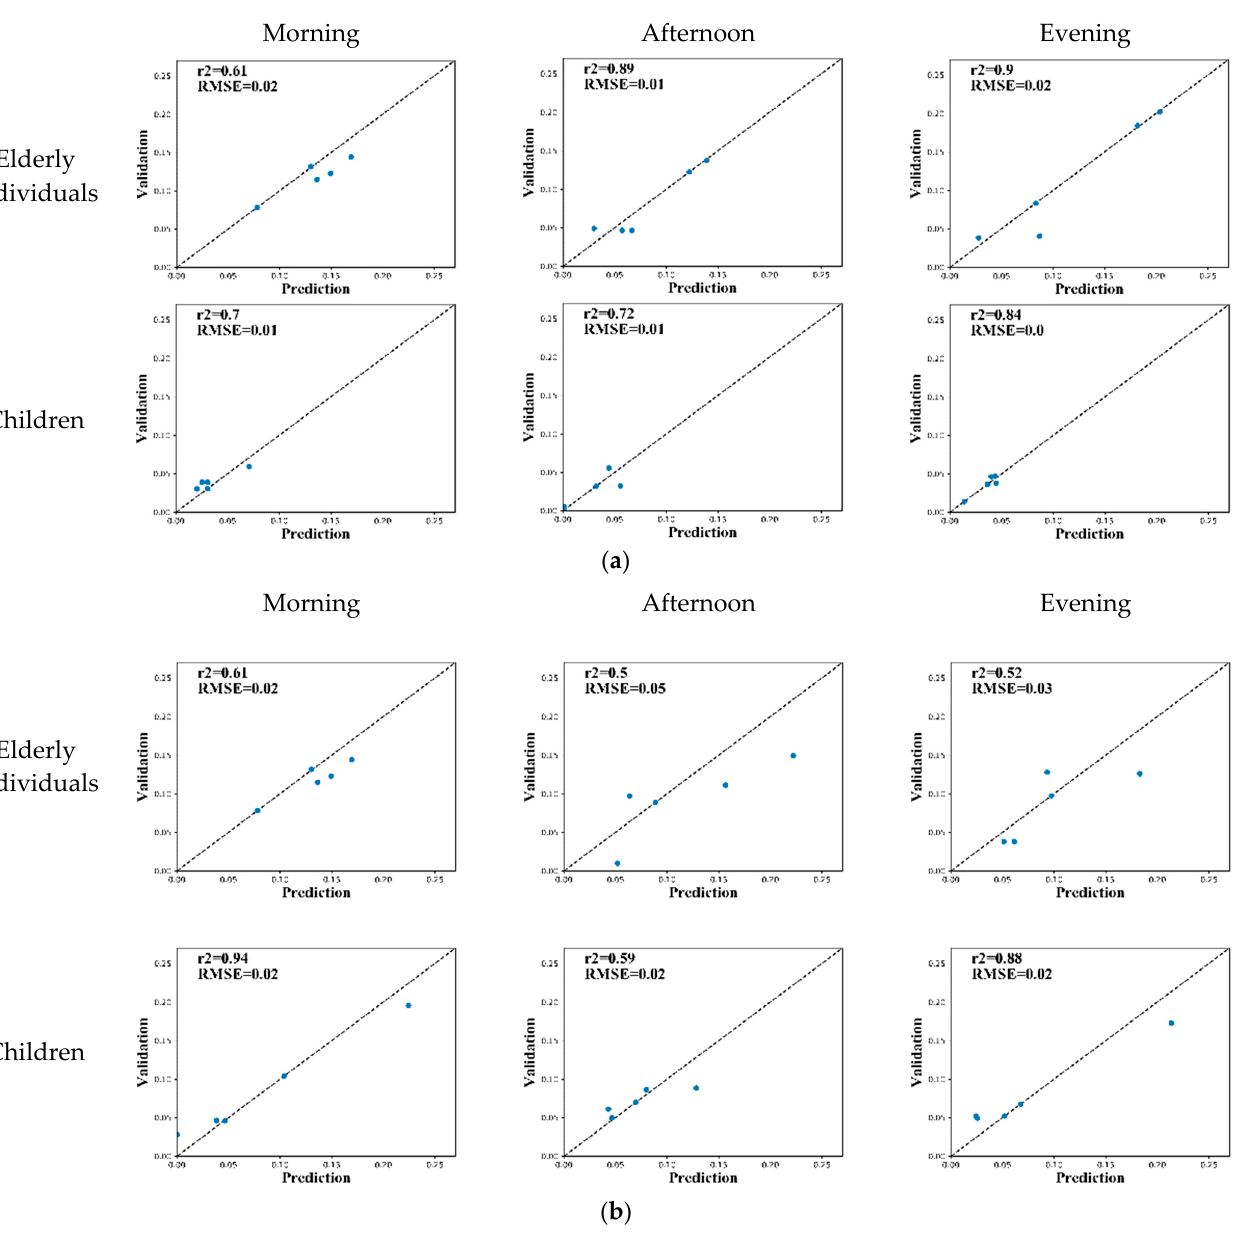
Figure 10. Accuracy of the population maps of the elderly and children for ( a ) weekdays and ( b ) weekends.